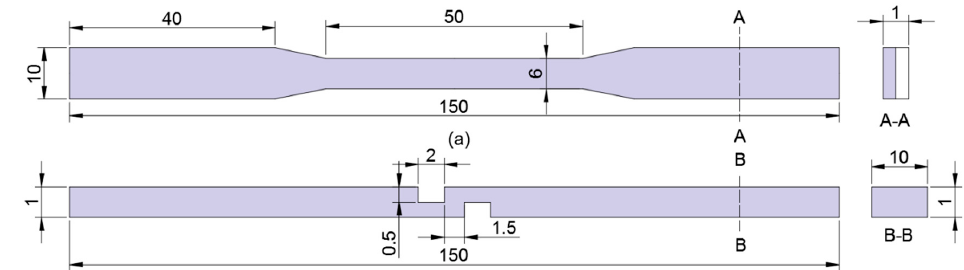
Figure 4. Dimensions of tensile and tensile-shear tests specimens.